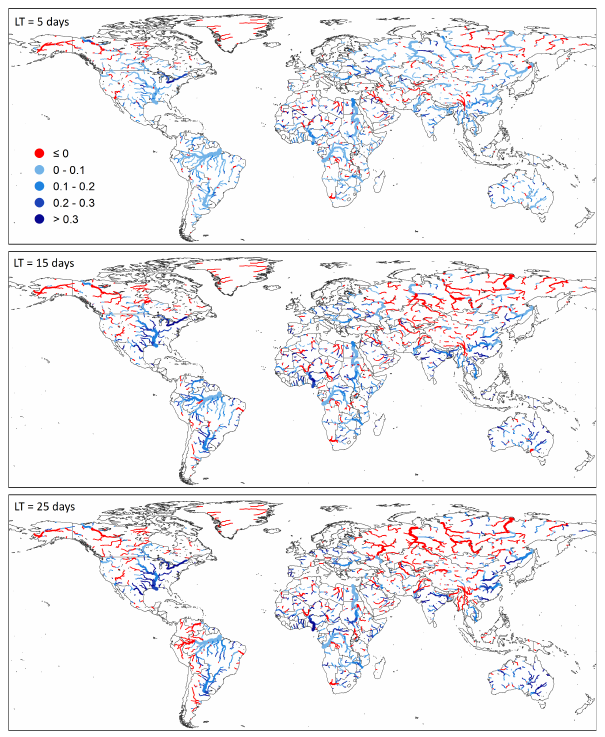
Fig. 7. CRPSS maps of ESPs for 2009–2010 against simulated cor- rected discharge climatology. Panels refer to lead time of 5, 15, and 25 days (top to